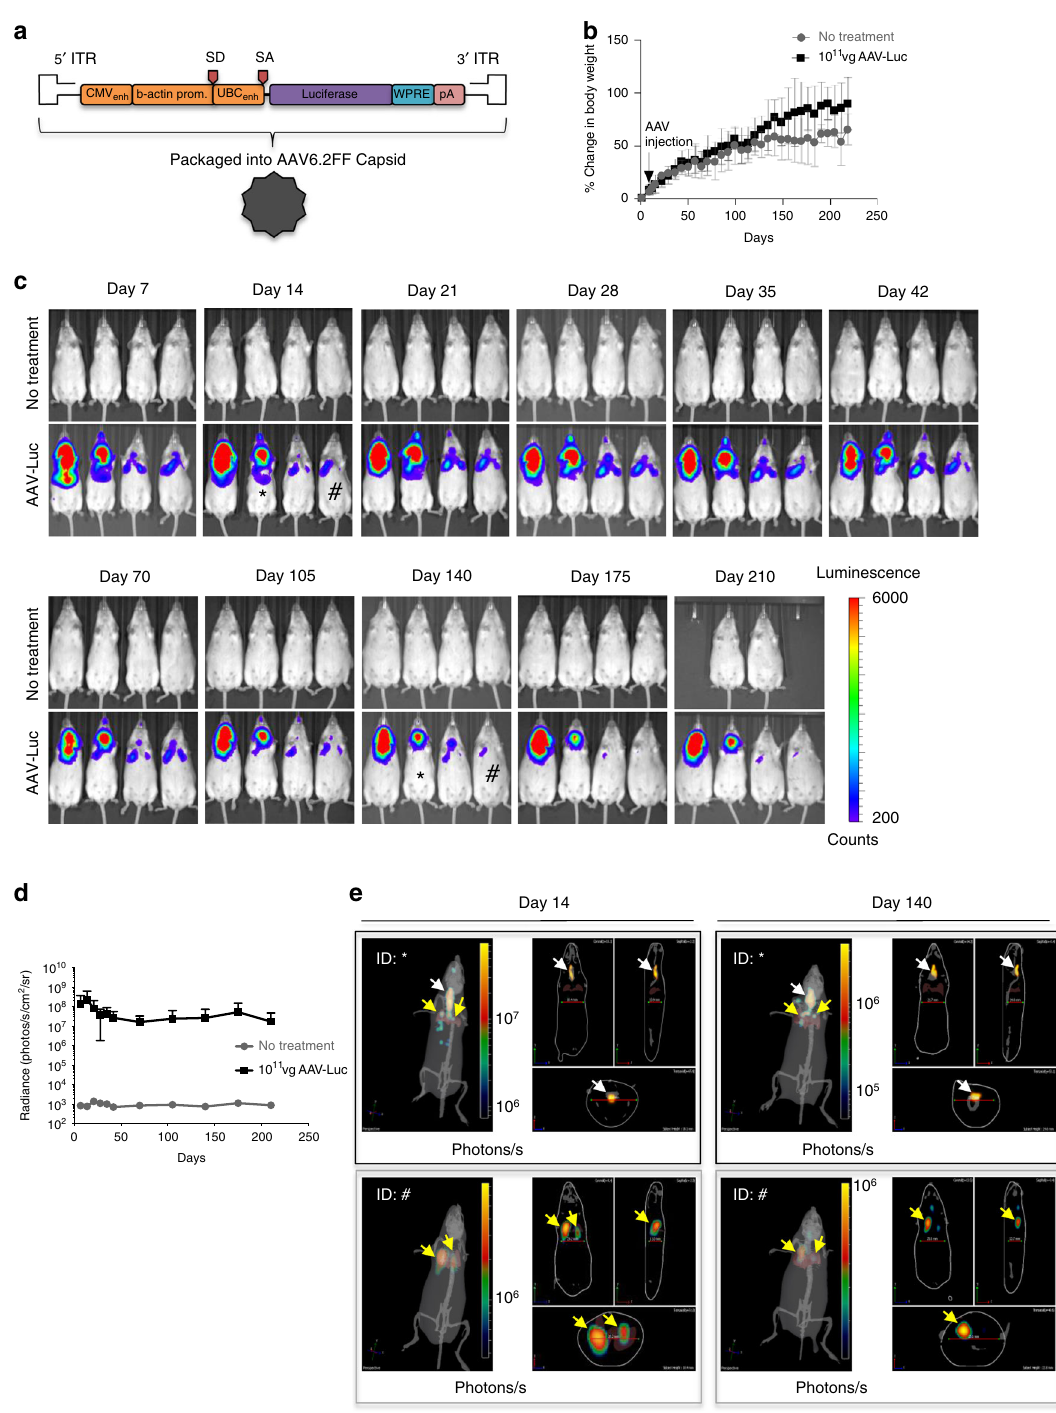
on dox following AAV administration (Fig. 4b, Supplementary Fig. 5b, c), AAV-mSPB mitigated the weight loss observed in AAV-Luc mice following dox removal (Fig. 4c). Three AAV-Luc mice died before the 3-day experimental endpoint and were not included in the assessment of lung function, while all AAV-mSPB mice survived until the harvest on day 3. Macroscopic tissue injury as indicated by lung lesions (yellow arrows) were observed in 6 out of 7 AAV-Luc mice (Fig.